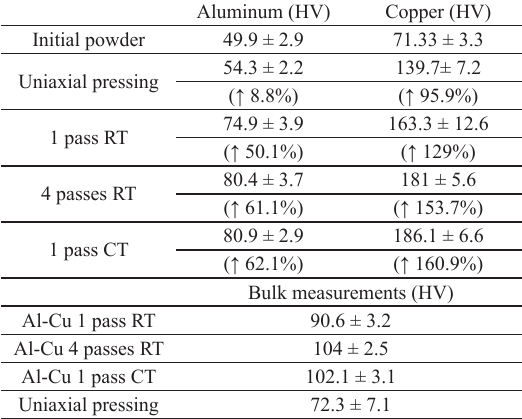
Table 3. Vickers hardness (HV) for initial powders and for the respective elements after ECAP passes at RT and CT. Bulk measurements of the composite is also